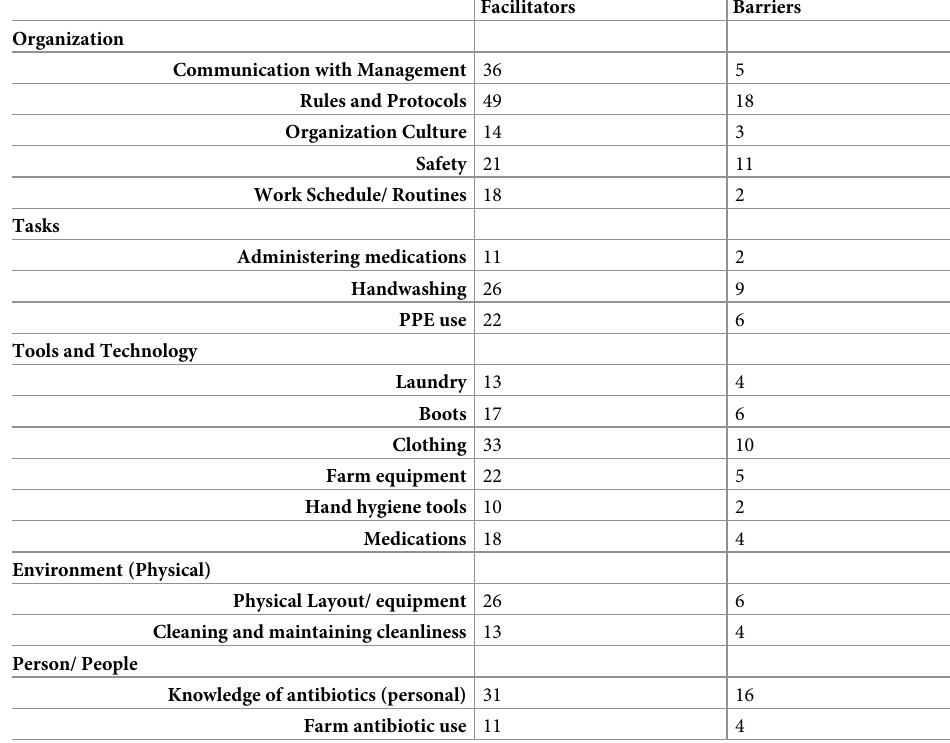
Table 1. Number of barriers and facilitators associated with each SEIPS